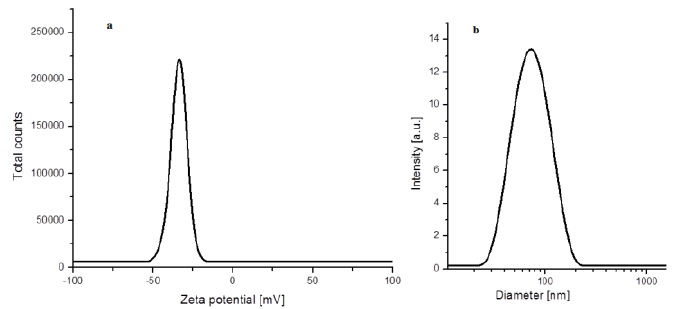
Figure 7. ( a ) Zeta potential. ( b ) hydrodynamic diameter of the obtained AgNPs.